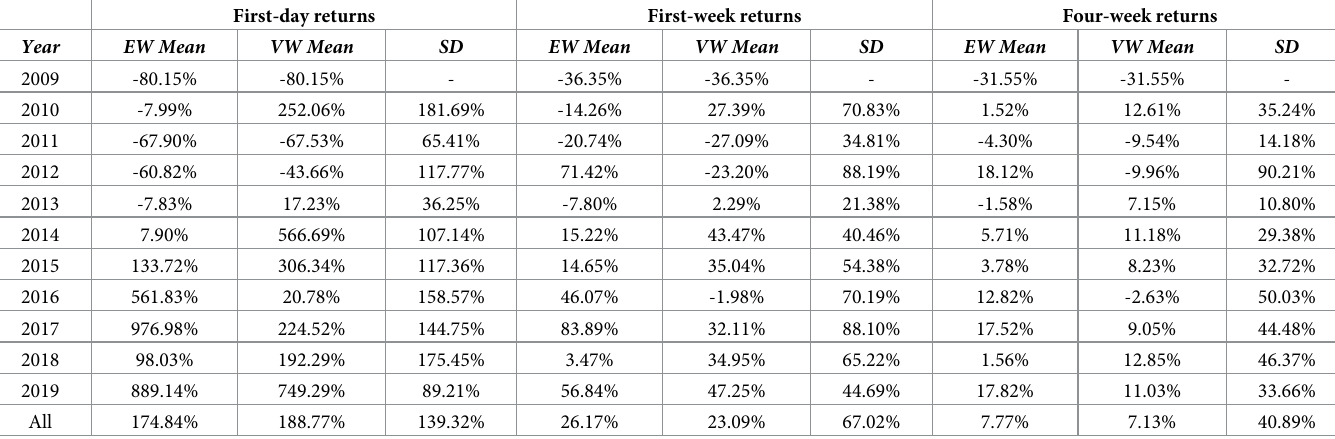
Table 4. Descriptive statistics of first-day, first-week and four-week returns on the issuing firms’ securities, where the mean returns and the standard deviations of returns have been transformed to the four-week horizon. First-day